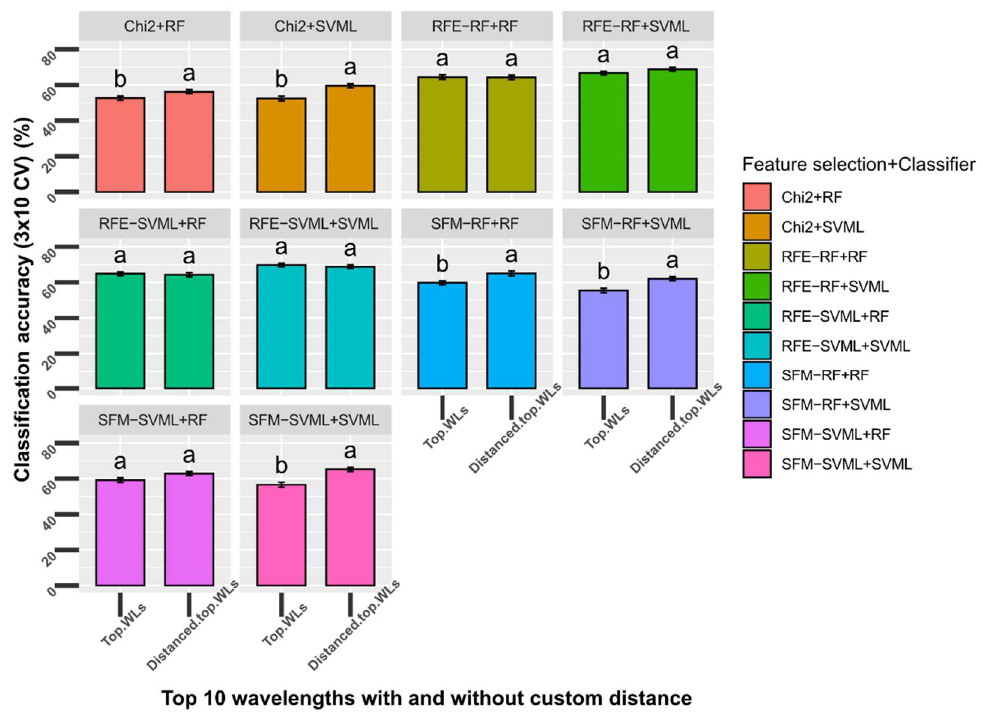
Figure 6. Comparison of top 10 selected wavelengths (WLs) with top 10 WLs with a minimum 20 nm distance between each feature for the classification of peanut stem rot. Five feature selection methods were tested: Chi2 = SelectKBest (estimator = chi-square); SFM-RF = SelectFromModel (estimator = random forest); SFM-SVML = SelectFromModel (estimator = support vector machine with linear kernel); RFE-RF = Recursive feature elimination (estimator = random forest); RFE-SVML = Recursive feature elimination (estimator = support vector machine with linear kernel). Each feature selection was tested using two classifiers: RF = random forest and SVML = support vector machine with the linear kernel. Bars with different letters were statistically different using a nonparametric Wilcoxon test with an α level of 0.05. Error bars indicate standard deviation of accuracy using stratified 10-fold cross-validation repeated three